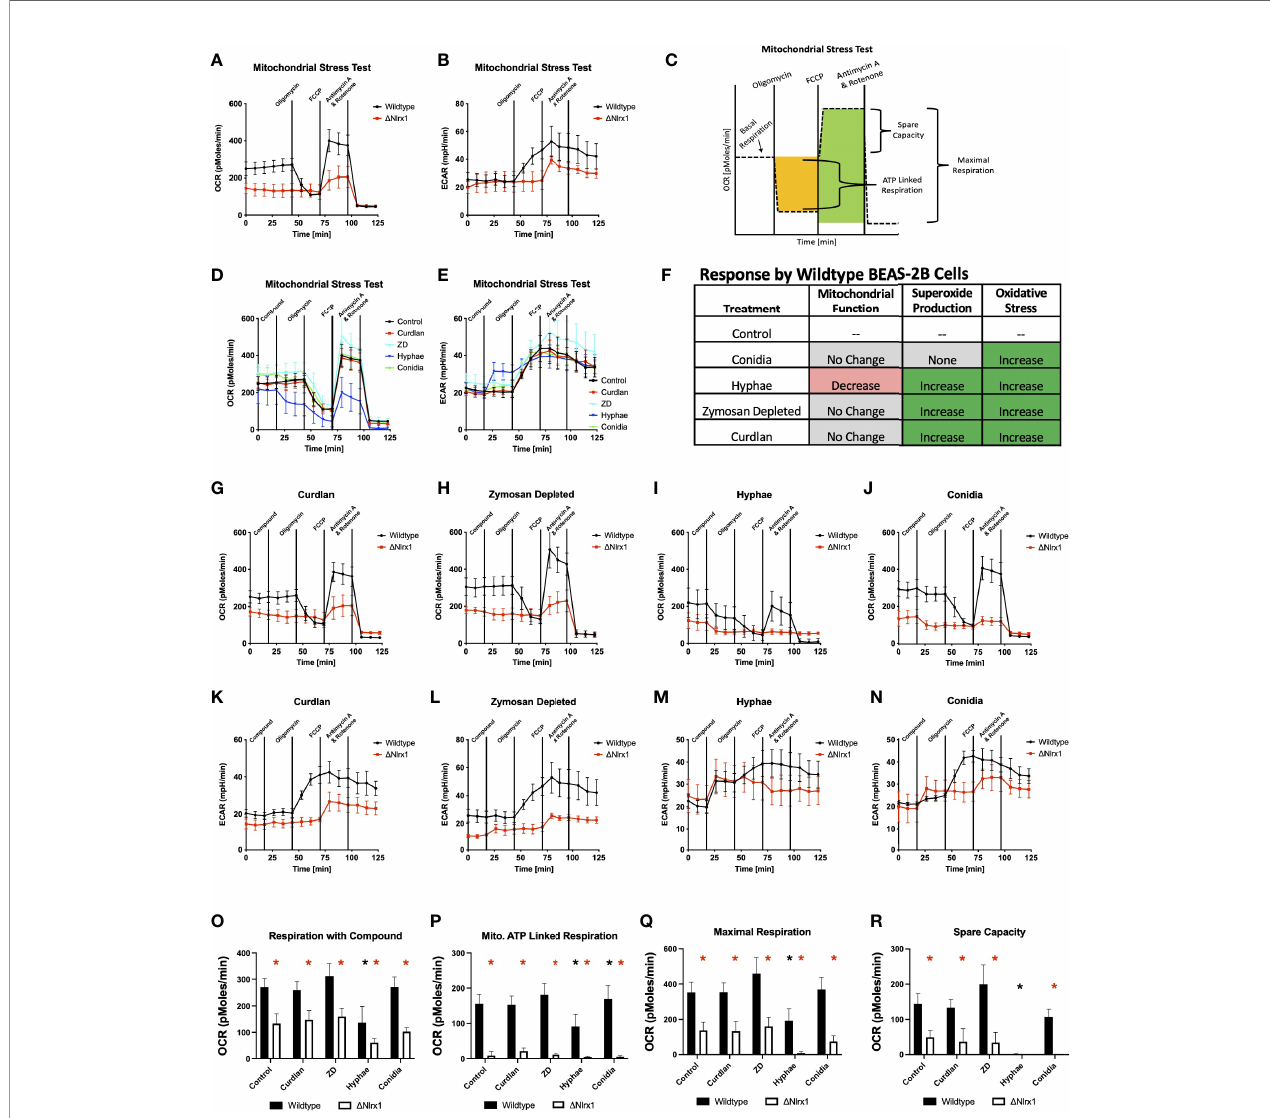
FIGURE 3 | Modulation of mitochondrial energetics within wild-type BEAS-2B cells in response to A. fumigatus conidia, hyphae, and a subset of fungal PAMPs is dependent on Nlrx1. (A) Oxygen consumption rate (OCR, pmol/min) and (B) extracellular acidi fi cation rate (ECAR, mpH/min) for wild-type and Nlrx1-de fi cient ( D Nlrx1) cells using a standardized mitochondrial stress test outlined in (C) . Measurement of (D) OCR and (E) ECAR by wild-type BEAS-2B cells during a modi fi ed mitochondrial stress test. The modi fi ed version of the assay provides an injection of fungal PAMPs (zymosan depleted and curdlan), killed hyphae, or killed conidia prior to the standard test. (F) Summary of mitochondrial function, superoxide production, and general reactive oxygen species production by BEAS-2B cells in response to killed conidia, hyphae, and fungal PAMPs zymosan depleted, and curdlan. (G – J) OCR and (K – N) ECAR by wild-type and D Nlrx1 BEAS-2B cells during a modi fi ed mitochondrial stress test using fungal PAMPs (zymosan depleted and curdlan), killed hyphae, or killed conidia. Calculated values for (O) respiration with compound, (P) mitochondrial ATP-linked respiration, (Q) maximal respiration, and (R) spare capacity. For (O – R) , black asterisk denotes p < 0.05 via Kruskal – Wallis test followed by a Dunn ’ s test for multiple comparisons against the control. Red asterisk denotes p < 0.05 between genotypes for a given treatment